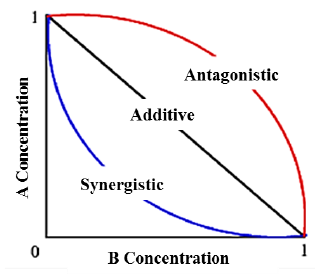
Figure 3. Schematic isobologram curve for determination of allelopathic interactions.